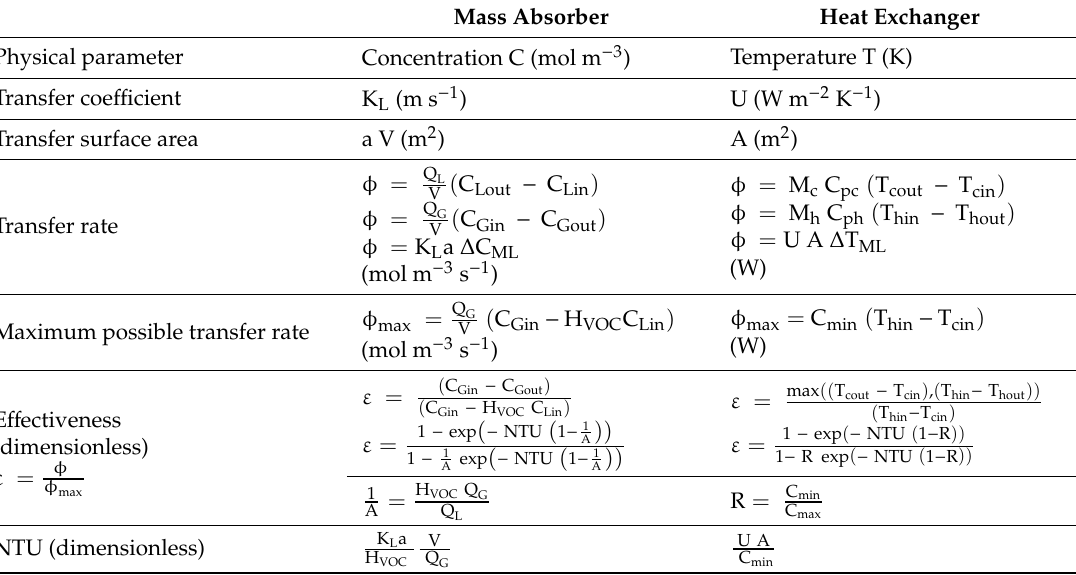
Figure 3. E ff ectiveness ( ε ) of a countercurrent gas–liquid absorber versus the number transfer units Figure 3. Effectiveness (ε) of a countercurrent gas–liquid absorber versus the number transfer units (NTU). (NTU). Table 1. The e ff ectiveness-NTU method for the countercurrent devices. Analogy between the gas–liquid mass absorber and the heat exchanger (see nomenclature for